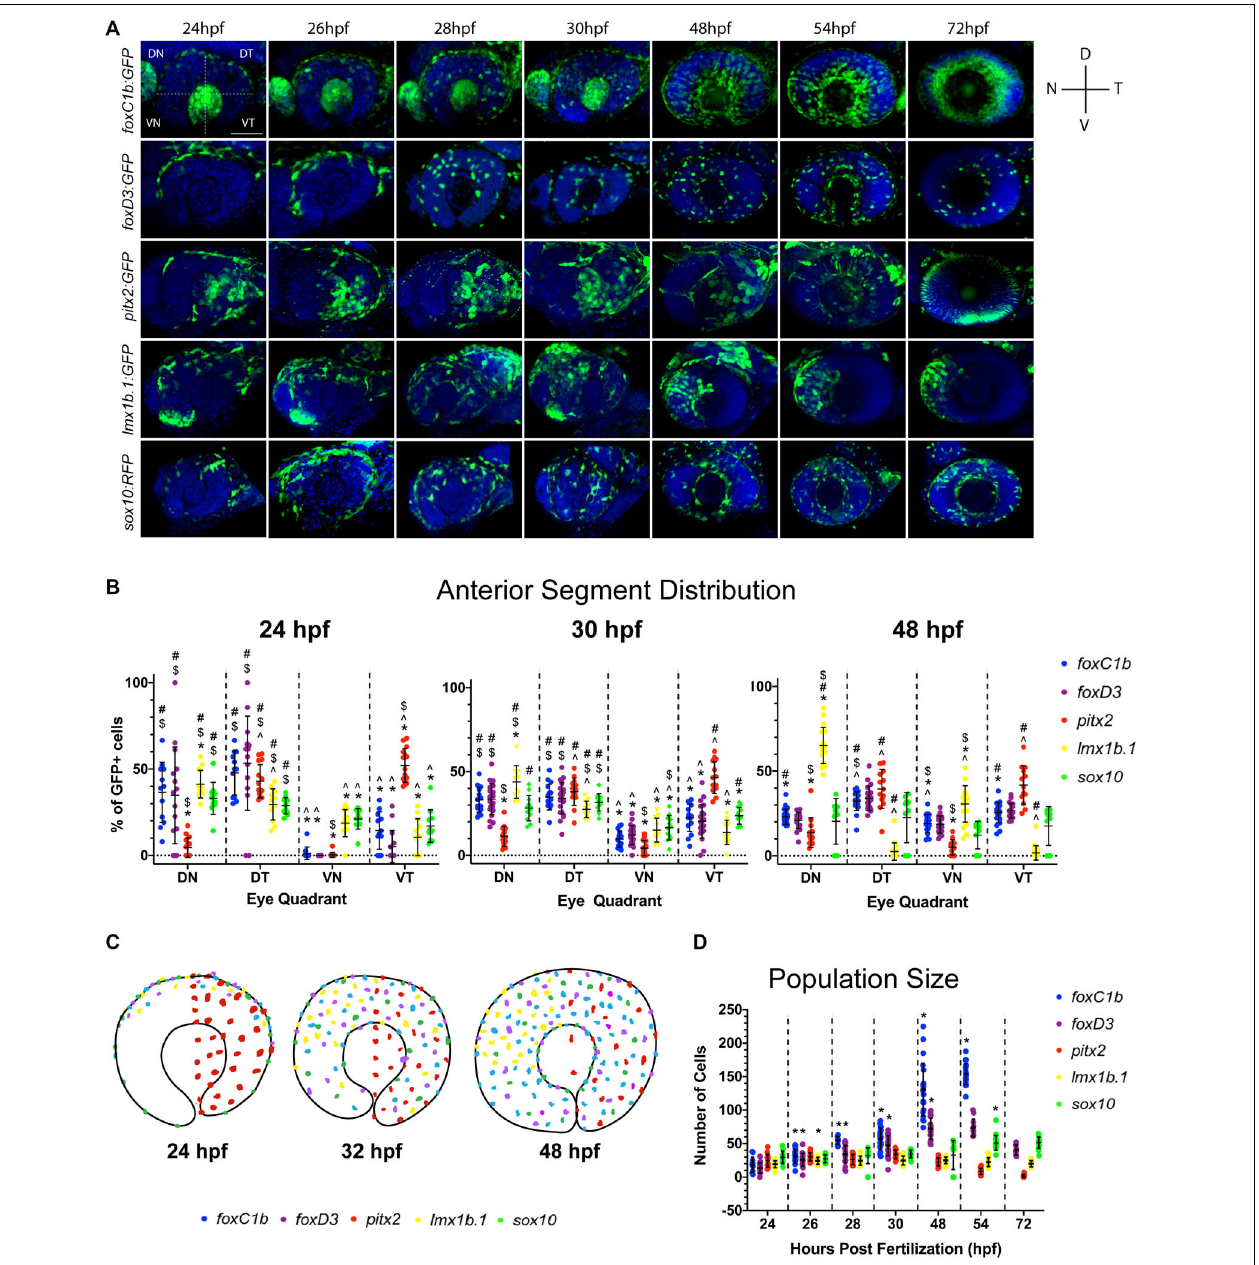
FIGURE 3 | Periocular mesenchyme subpopulation distribution analysis. (A) 3D rendering of confocal stacks encompassing the AS in POM transgenic lines between 24 and 72 hpf. GFP+ cells are green, DNA was stained with DAPI (blue). DN, dorsal-nasal; DT, dorsal-temporal; VN, ventral-nasal; VT, ventral-temporal. Scale bar = 50 µ m. (B) Distribution of quantified GFP+ cells within each AS quadrant (DN, DT, VN, and VT) at 24, 30, and 48 hpf. Distribution is represented as an average percentage of the total number of GFP+ in each quadrant of the AS for each transgenic line. Statistically significant difference ( p < 0.05): * vs. DT, # vs. VN, $ vs. VT and ˆ vs. DN. (C) Model of POM colonization at 24, 30, and 48 hpf. (D) Average AS cell population size for each transgenic line at 24–72 hpf. * indicates statistically significant ( p < 0.05) change from previous time